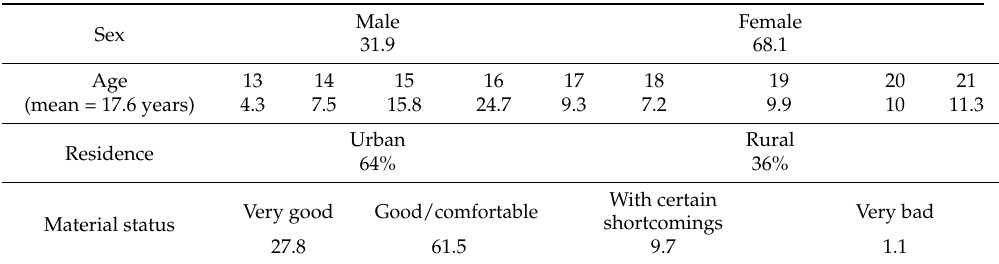
Table 1. Research sample (%).